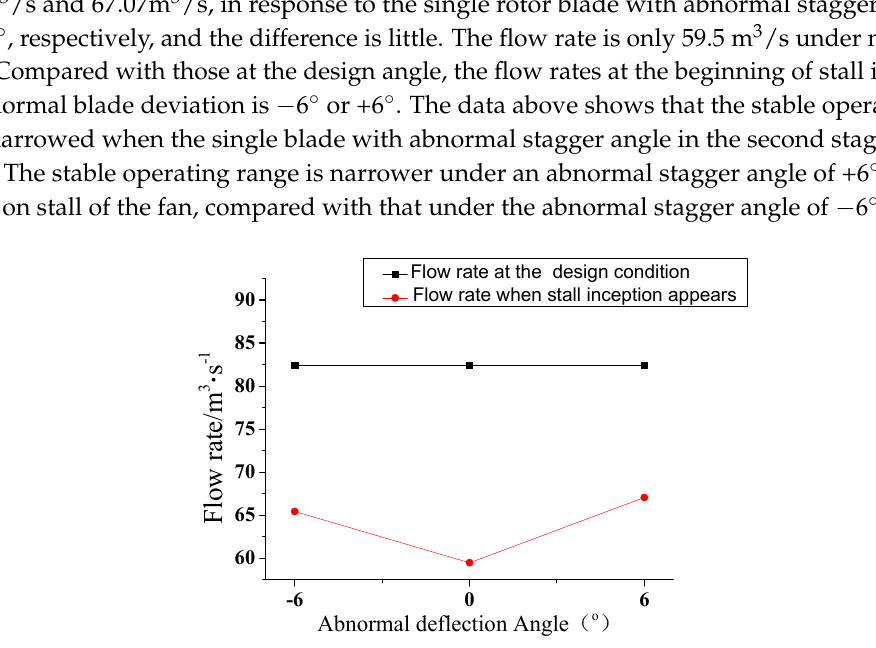
Figure 6. The flow rate when stall inception appears in.